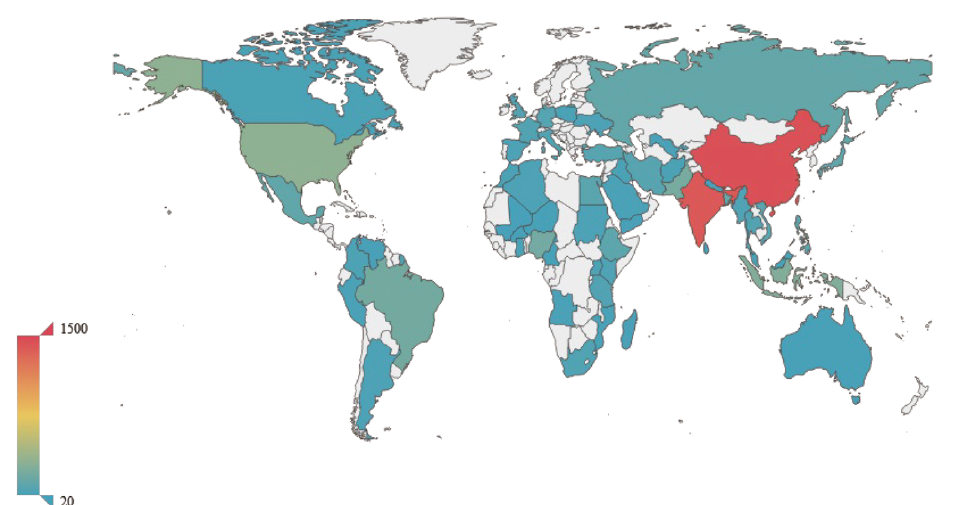
Figure 2. The selection of countries for the modeling analysis is based on the countries’ population size. The red color represents a high